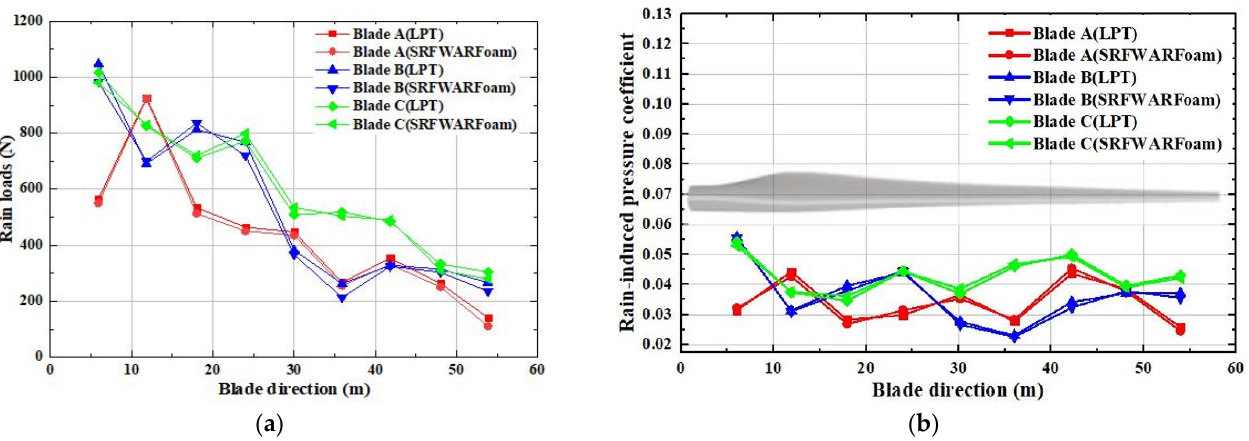
Figure 5. The distribution of rain-induced pressure ( a ) and its coefficient ( b ) on the surfaces of blades.